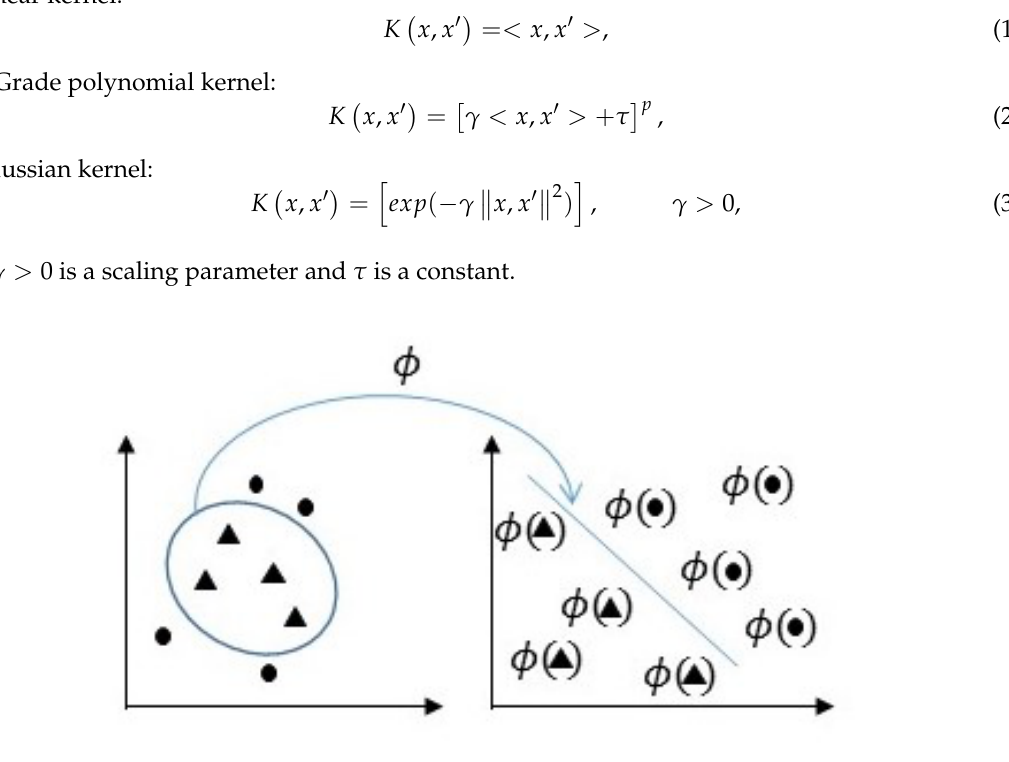
Figure 5. Representation of the transformed space for nonlinear